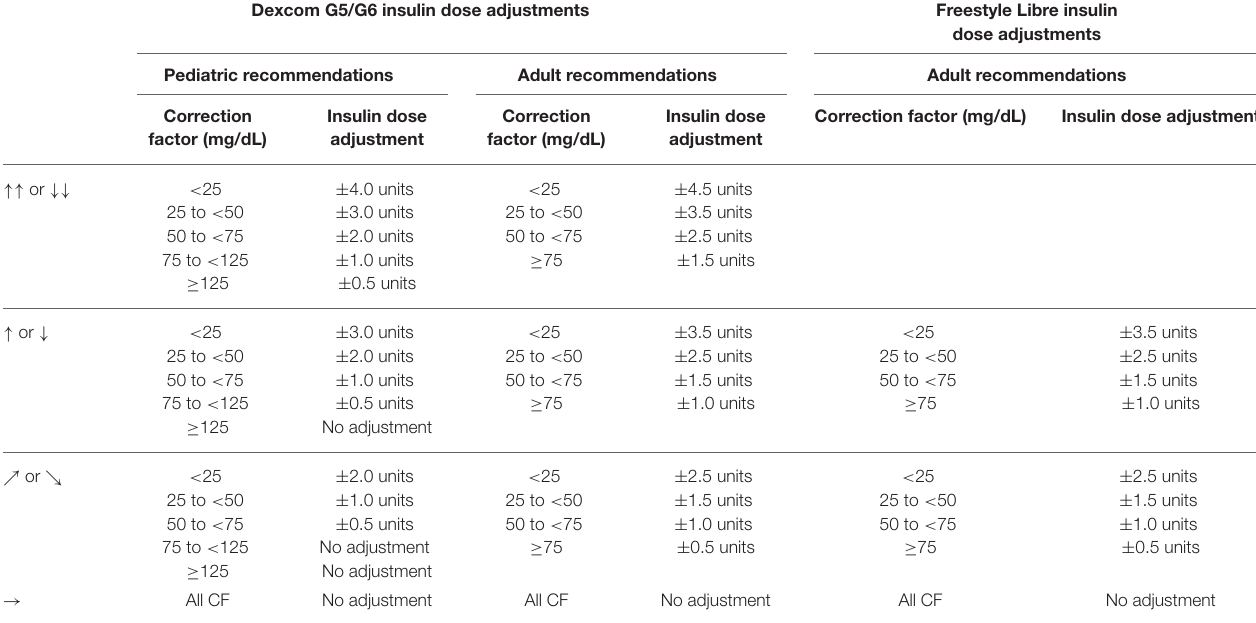
TABLE 6 | Pediatric and adult insulin dose adjustments for trend arrows for Dexcom G5 and G6 and Freestyle Libre [adapted from Laffel et al. (33), Aleppo et al. (34), and Kudva et al. (